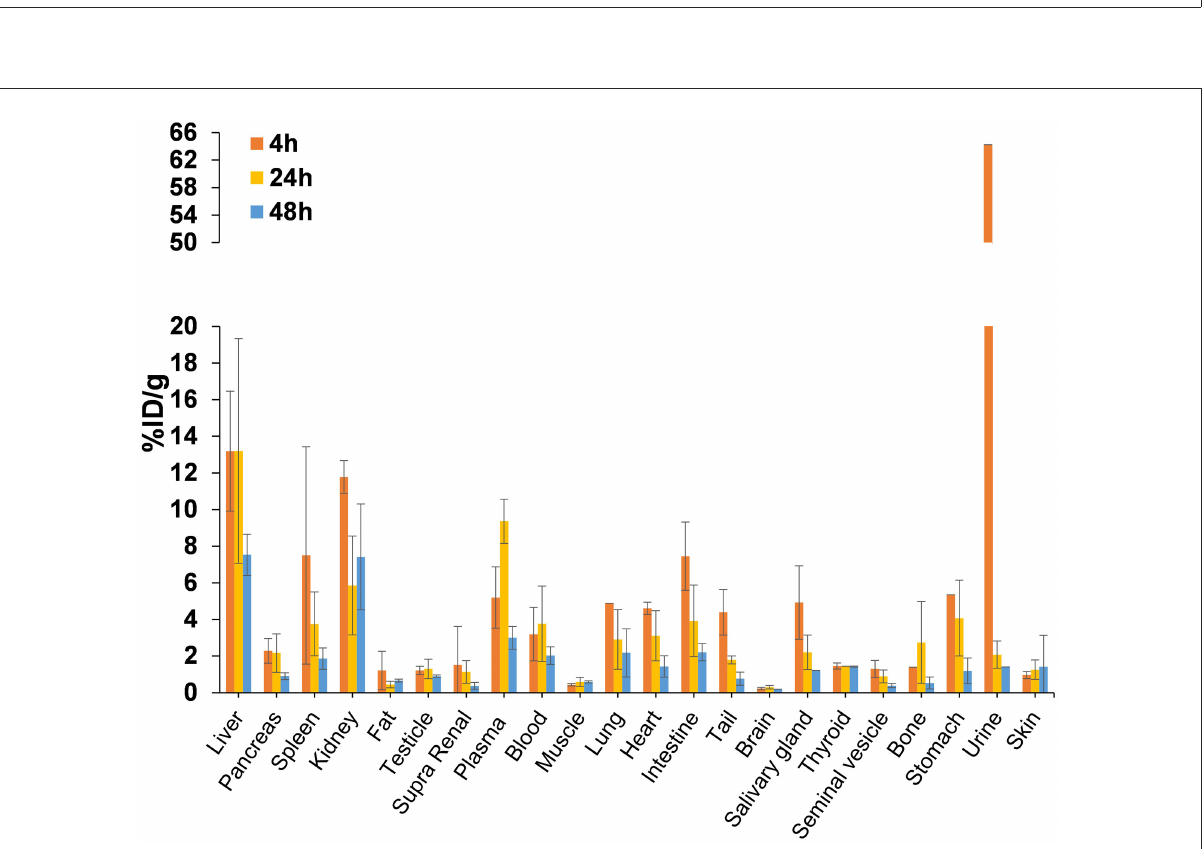
FIGURE3 Biodistribution profile of [ 64 Cu]NOTA-C3-TP in Balb/c mice ( n = 3/group) at 4, 24, and 48h p.i